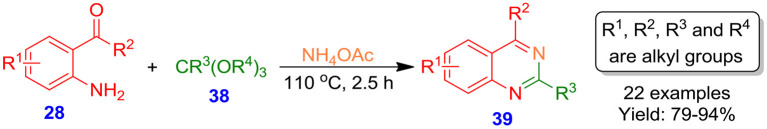
Reactions of 2-aminoarylketones with orthoesters under catalyst- and solvent-free conditions.